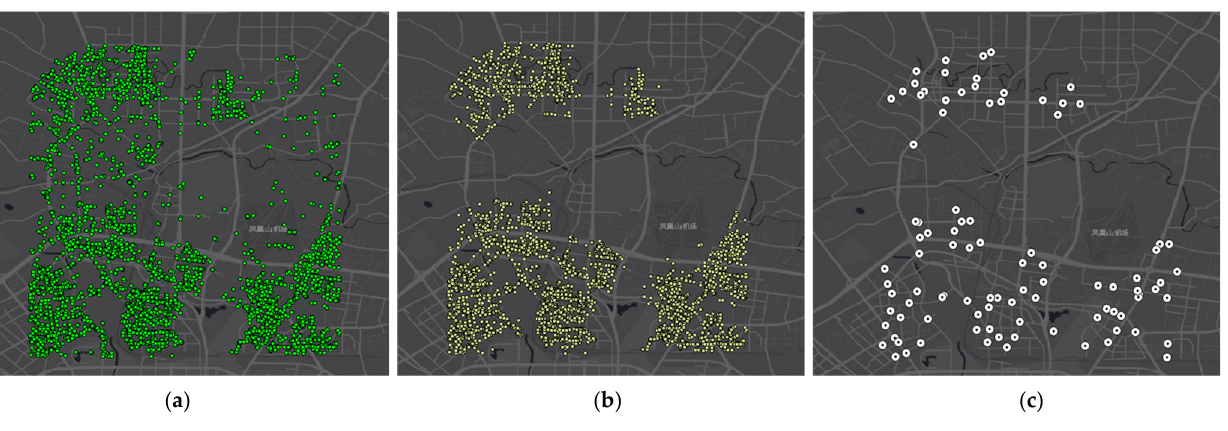
Figure 6. Shuttle stops generation. ( a ) All O/D locations; ( b ) clustered locations; ( c ) generated shuttle stops.